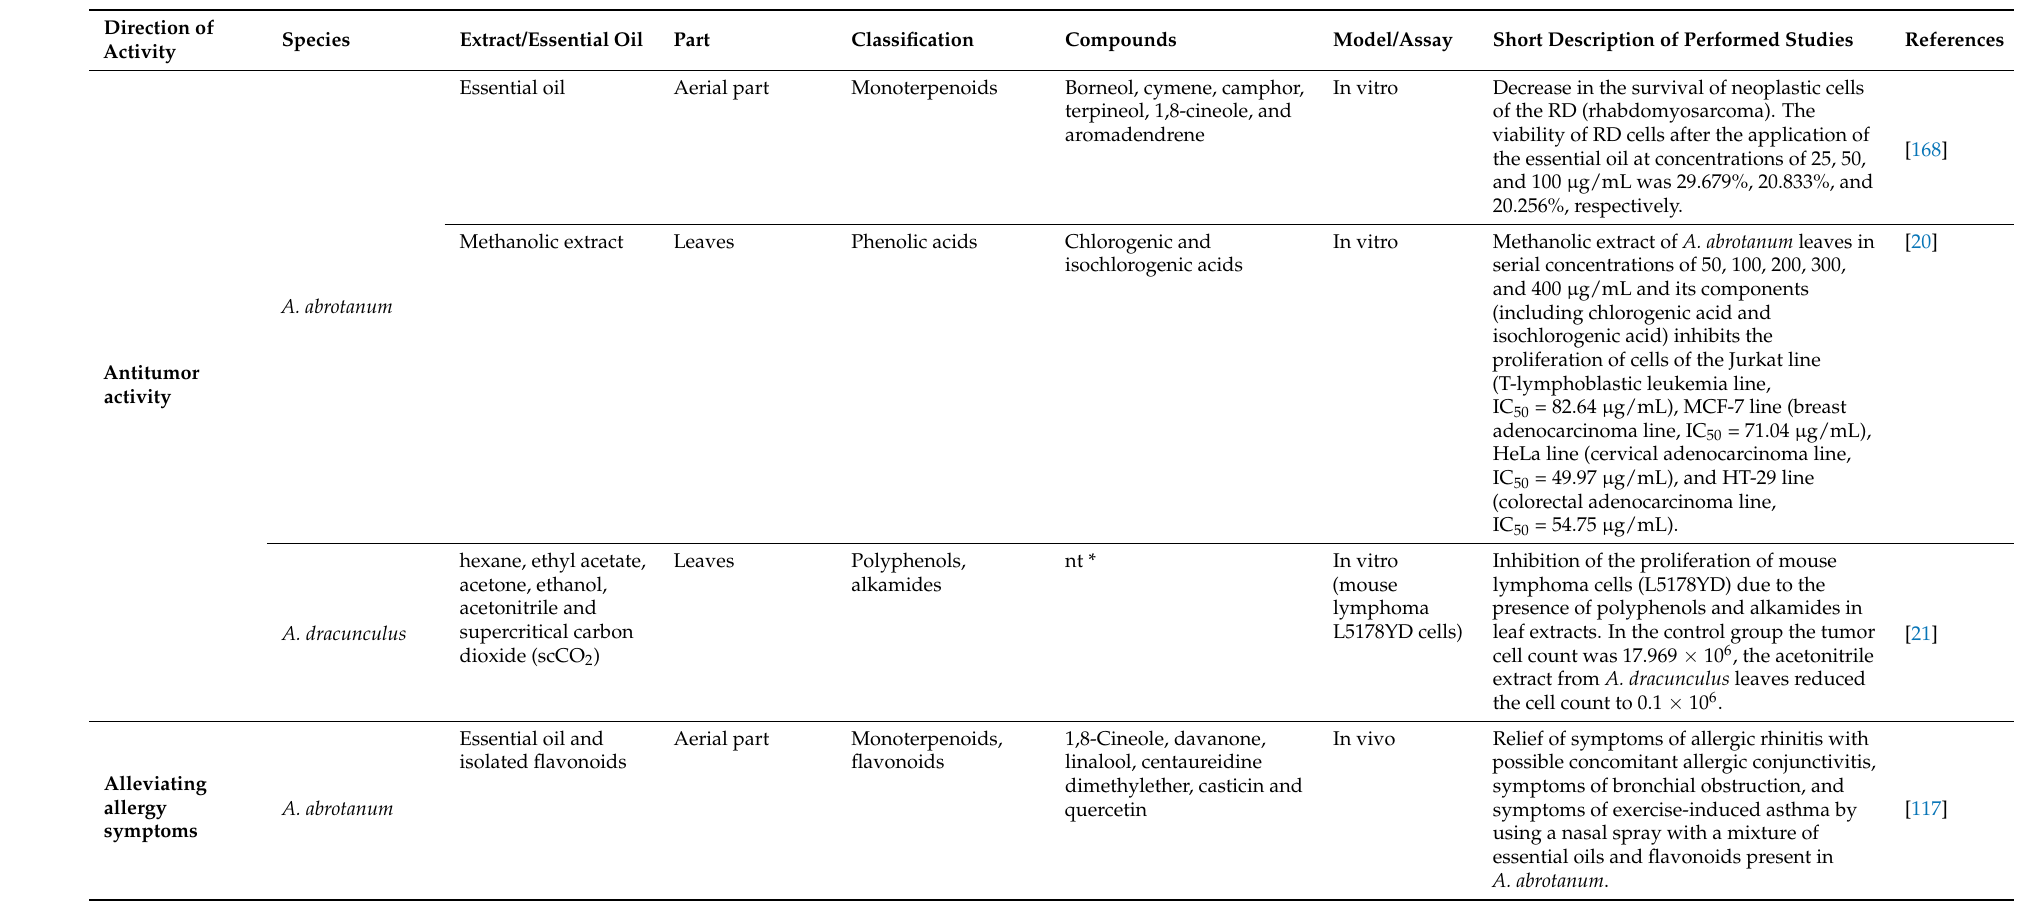
Table 5. Biological activities of Artemisia